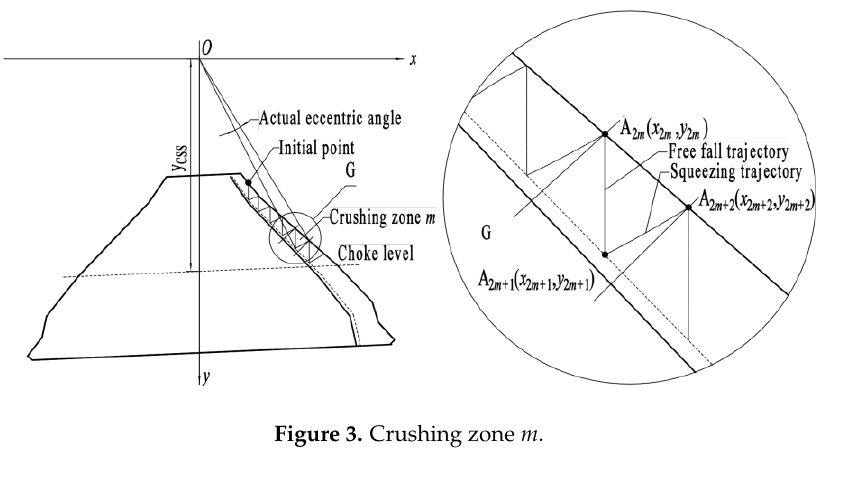
Figure 3. Crushing zone m .